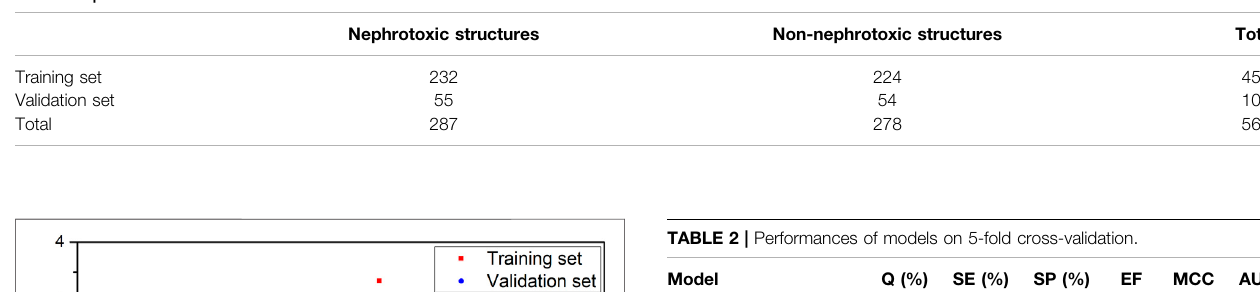
TABLE 1 | The number of structures in the data set.